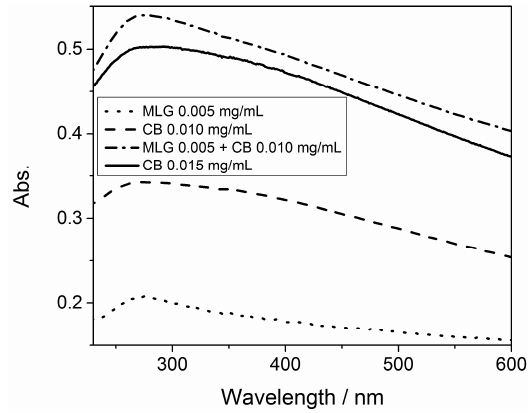
Figure 2. UV-Vis absorption of water dispersions of CB, MLG and their mixture.